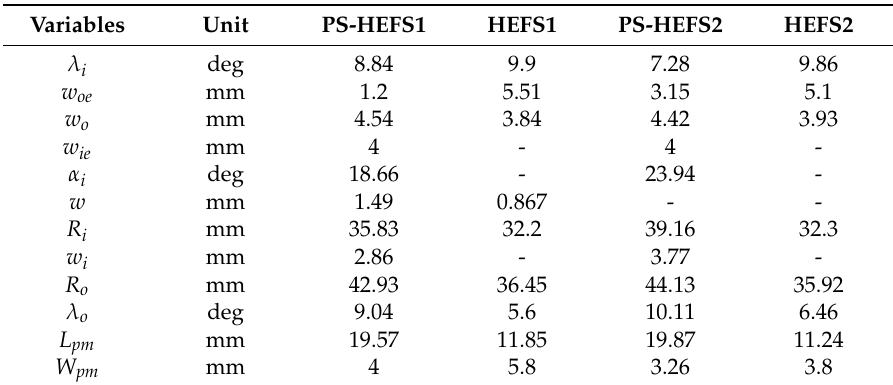
Table 3. Optimal values of design